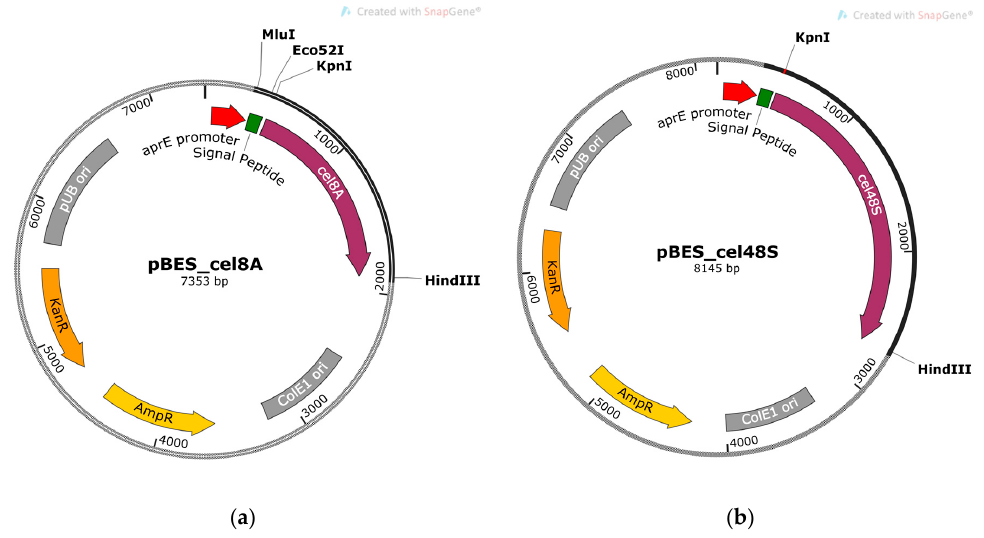
Figure 1. Physical maps of the recombinant constructs containing cellulase genes cel8A and cel48S of A. thermocellus DSM 1237: ( a ) pBES_cel8A; ( b ) pBES_cel48S. The signal peptides library was cloned between Mlu I and Eco 52I sites in